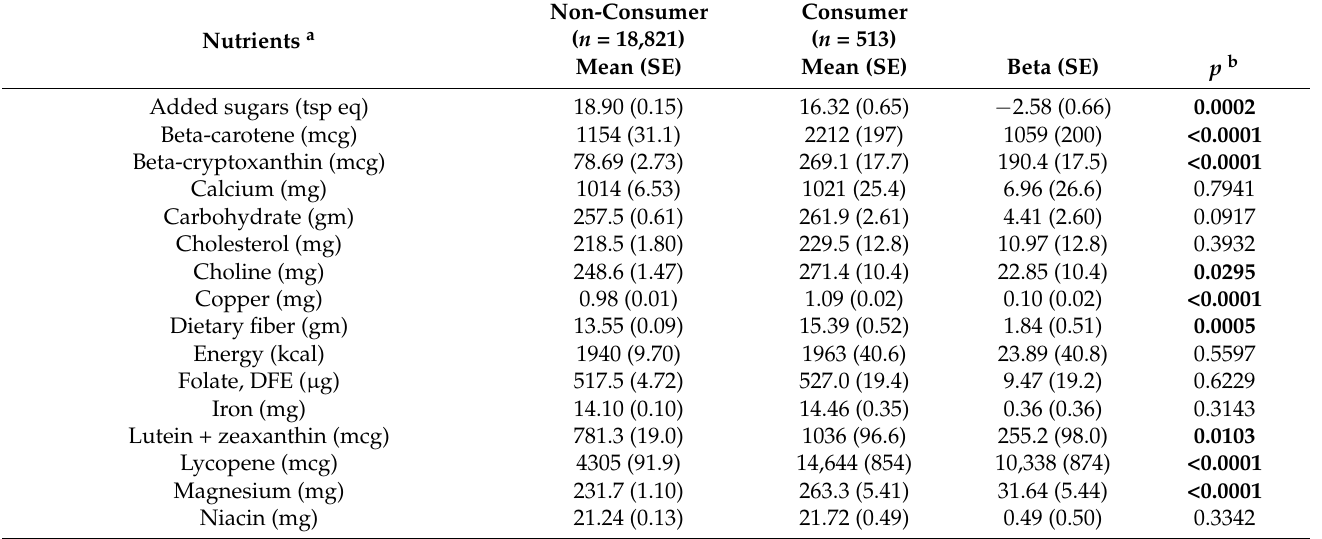
Table 6. Energy and nutrient intakes in children watermelon consumers ( n = 513) and non-consumers ( n = 18,821), NHANES 2003–2018, gender combined